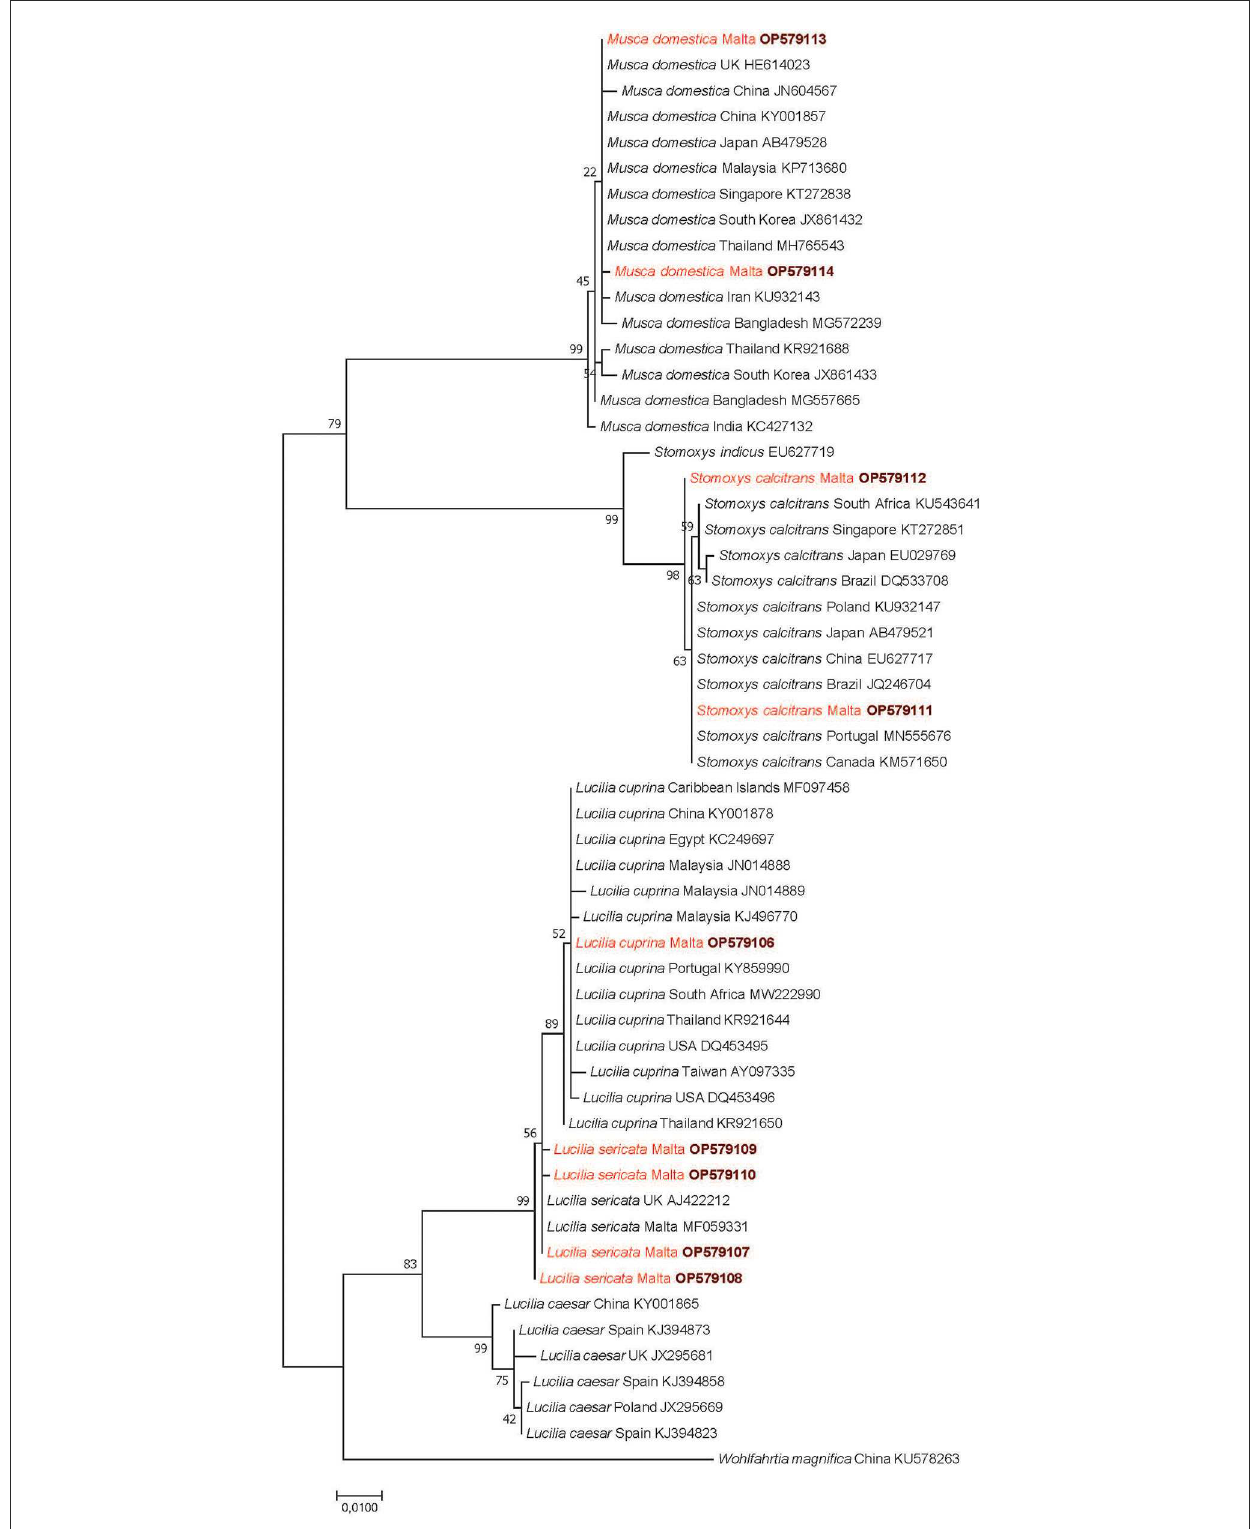
FIGURE3 Phylogenetic tree of Diptera based on the cox1 gene, made with the Maximum Likelihood method and the Jukes-Cantor model. In each row, after the species or genus name, the country of origin and the GenBank accession number are shown. Sequences obtained in this study are in red and bold accession numbers. The analysis involved 56 nucleotide sequences and 1000 bootstrap replications. There were a total of 631 positions in the final dataset. The scale-bar indicates the number of substitutions per